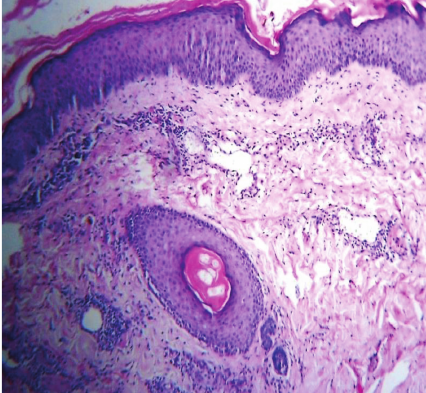
Figure 3: Hyperkeratosis and upper dermal infiltrate. (H&E: × 100).